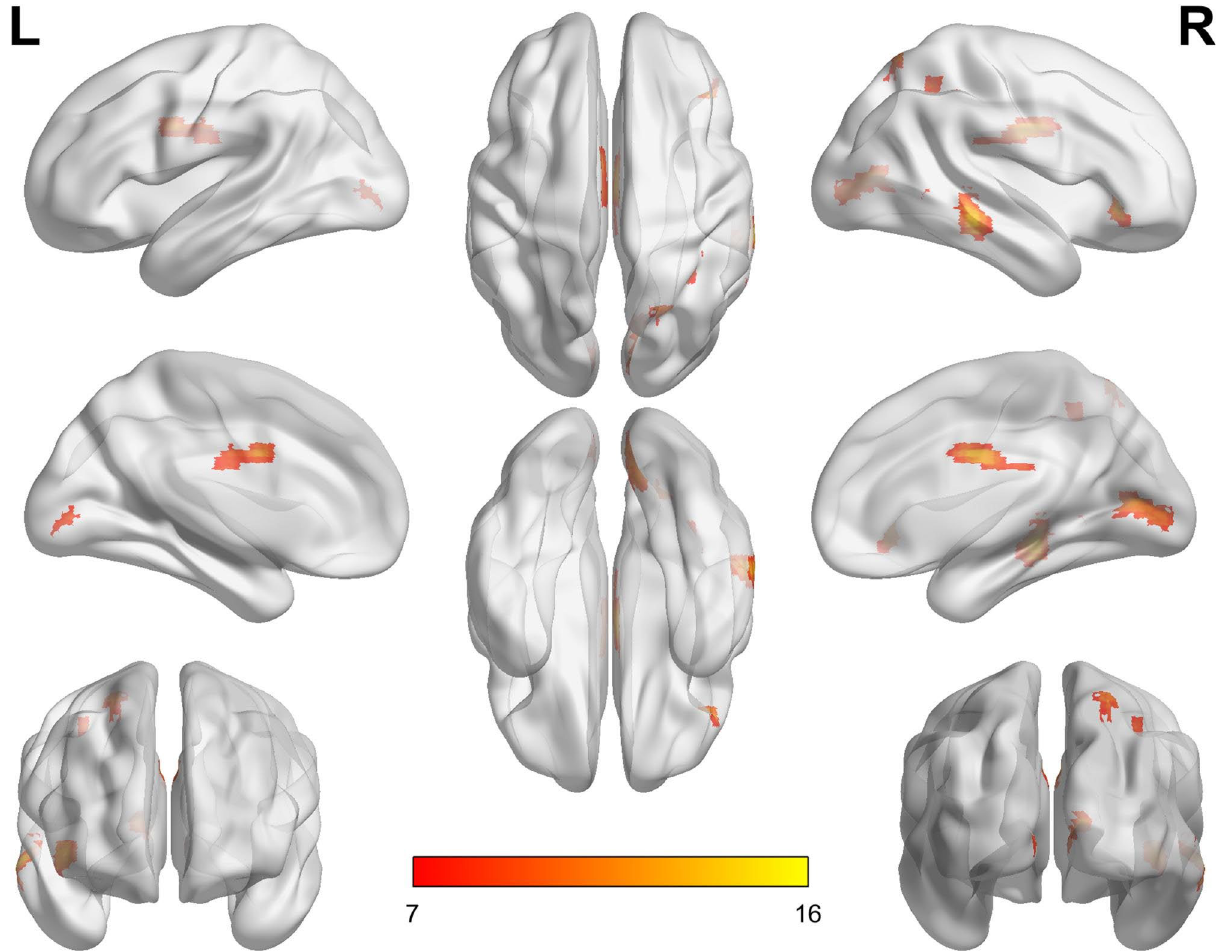
Fig. 2 Differences in the functional connectivity of the right caudate nucleus among the CM, EM, and HC groups. The color bar represents the F-values Note: L, left; R, right; CM, chronic migraine; EM, episodic migraine; HC, healthy